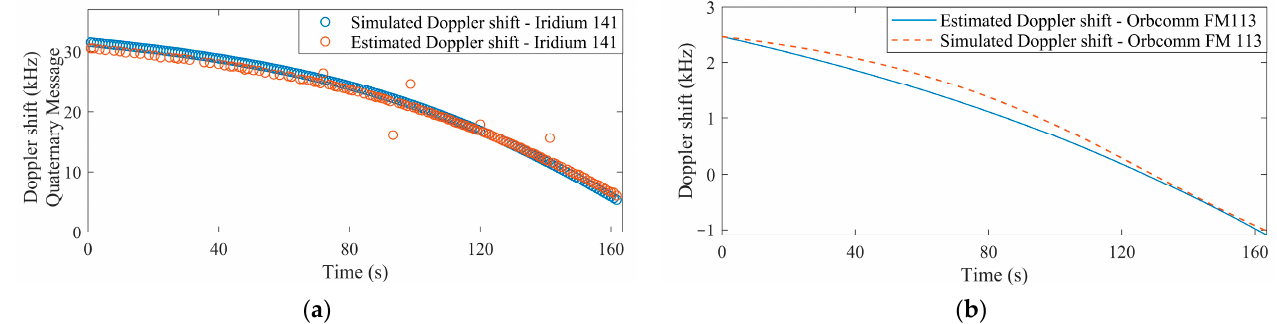
Figure 8. Estimated and simulated Doppler shifts for ( a ) Iridium-141 satellite, and ( b ) Orbcomm FM-113 satellite.